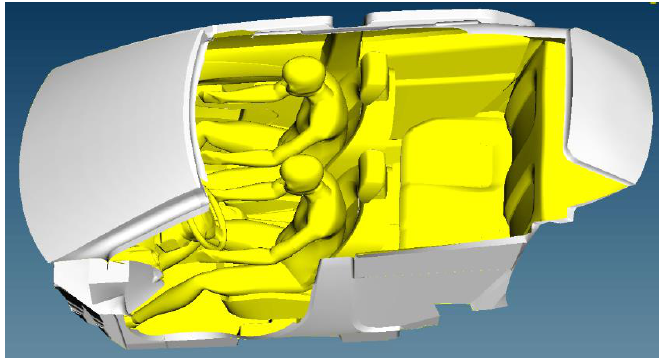
Figure 1. Geometric model of passenger compartment with driver and passenger.